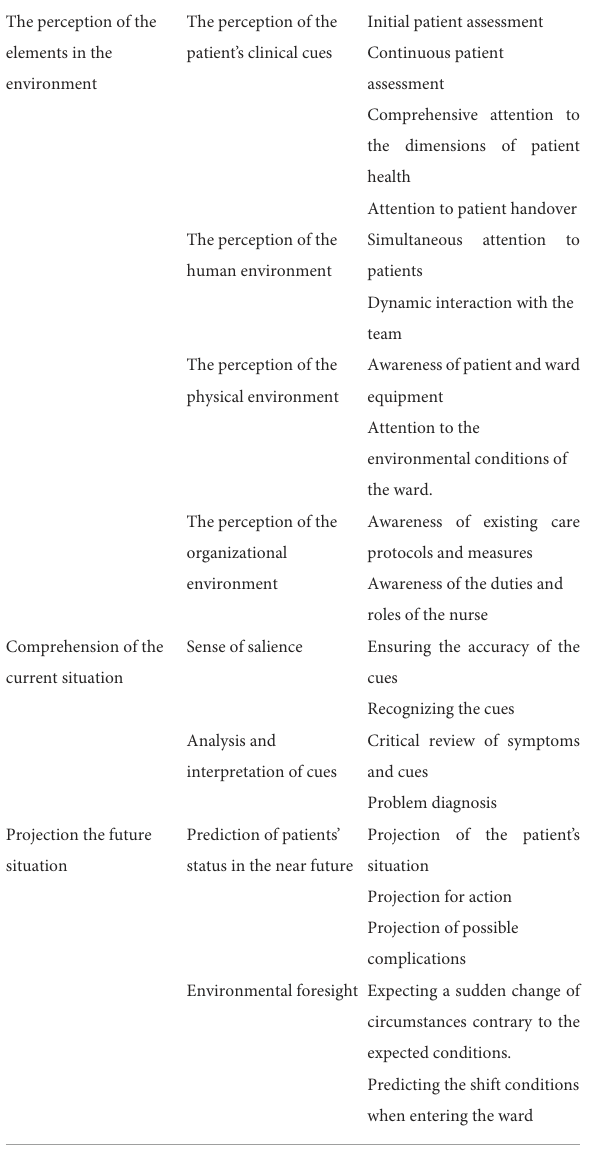
TABLE 3 Main categories, generic categories, and subcategories of SA in ICU